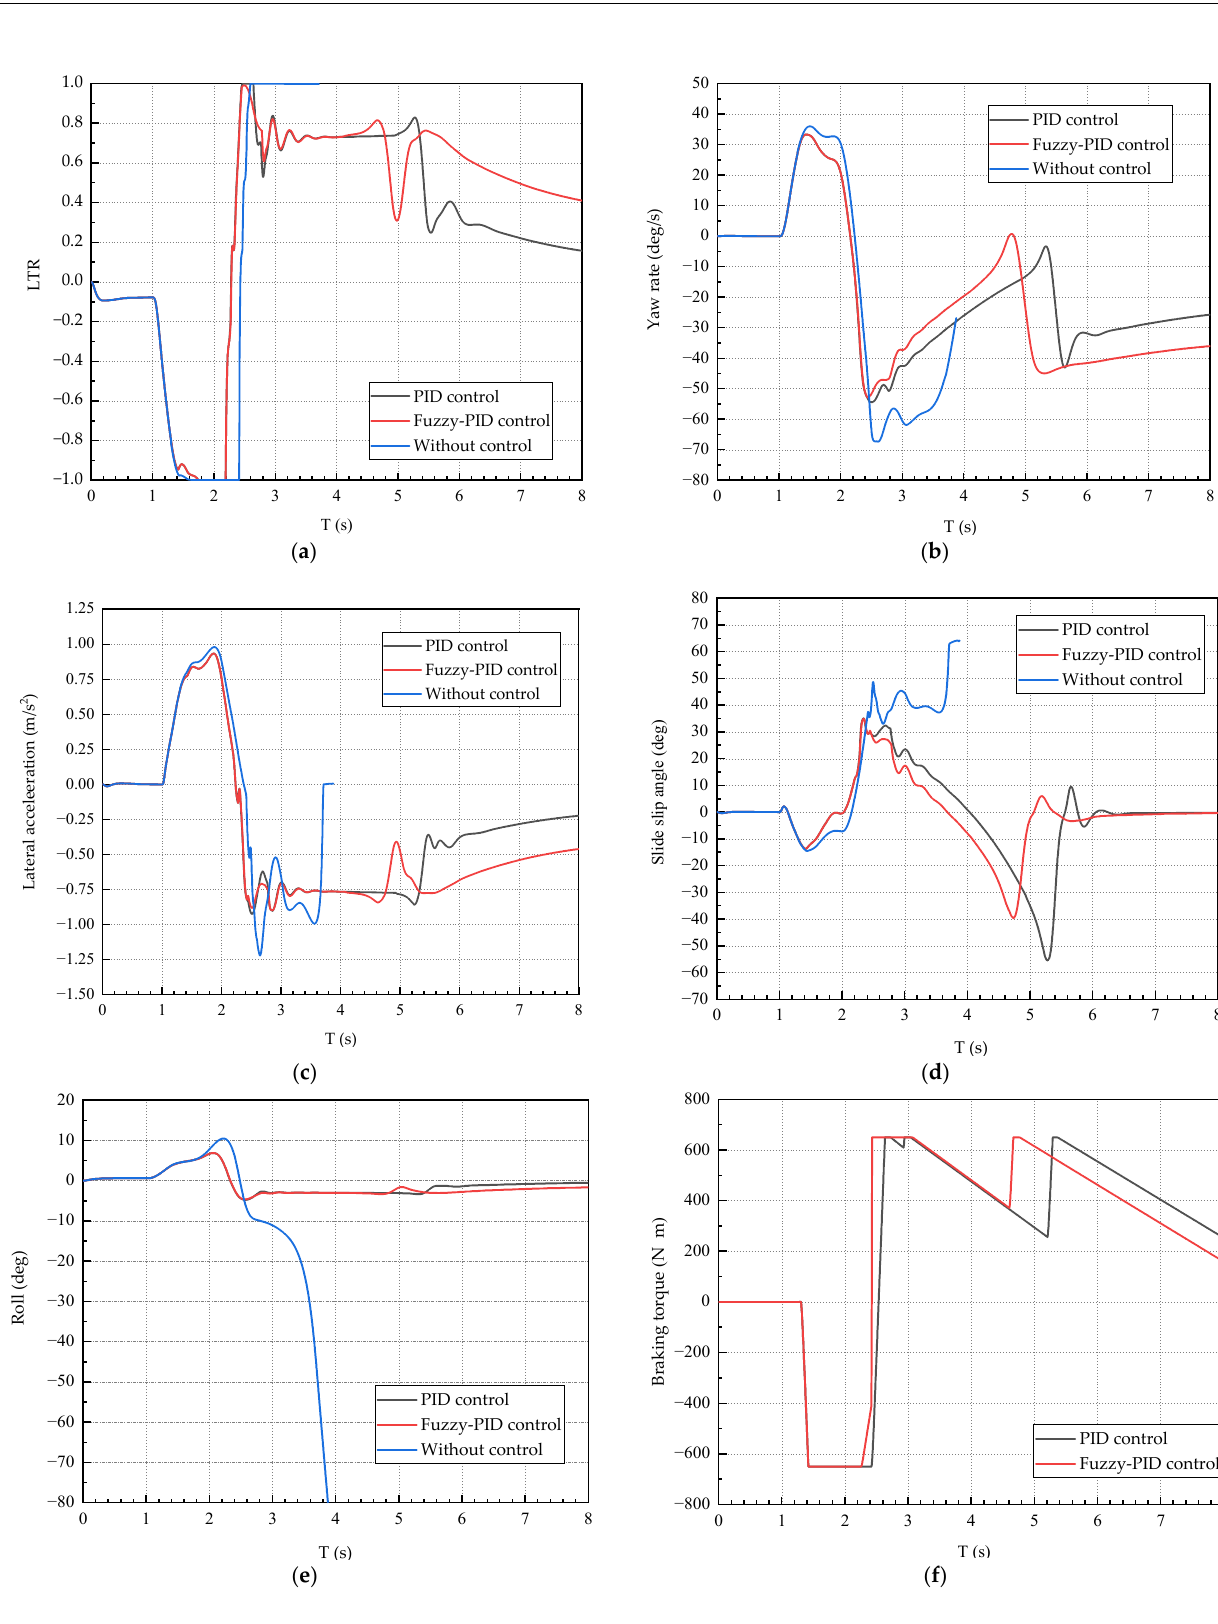
Figure 15. Response curve of fishhook steering condition: ( a ) LTR; ( b ) yaw rate; ( c ) lateral acceleration; ( d ) side slip angle; ( e ) roll; and ( f ) braking torque.